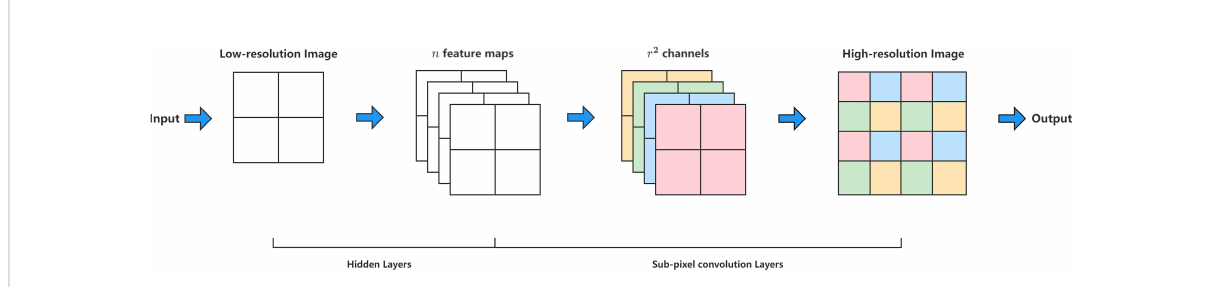
FIGURE 3 The high-resolution image is obtained by upsampling the low-resolution image using subpixel convolution. By super-resolution, upsampling a high-dimensional low-resolution feature map to obtain a low-dimensional high-resolution image can effectively recover the detailed information in the feature